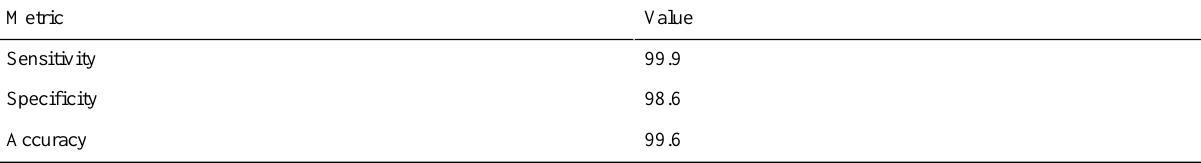
Table 2. Performance of the proposed method in the test data set.